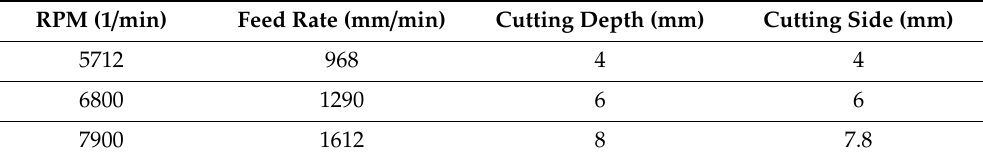
Table 1. Process parameter for milling process monitoring.